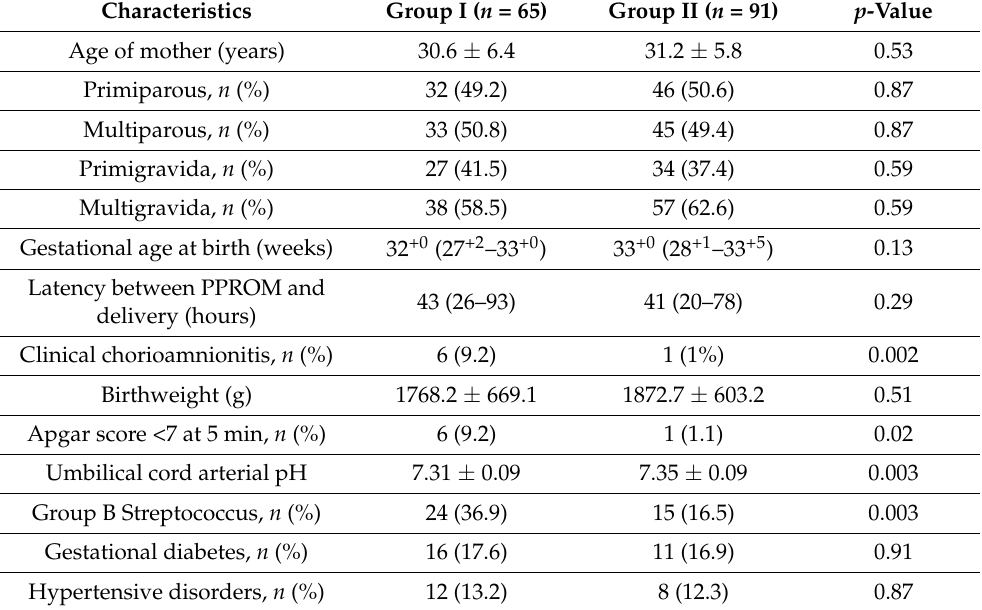
Table 1. Characteristics of patients according to the groups. PPROM, preterm premature rupture of membranes, Group I, patients with diagnosed histological chorioamnionitis, and Group II, patients without diagnosed histological